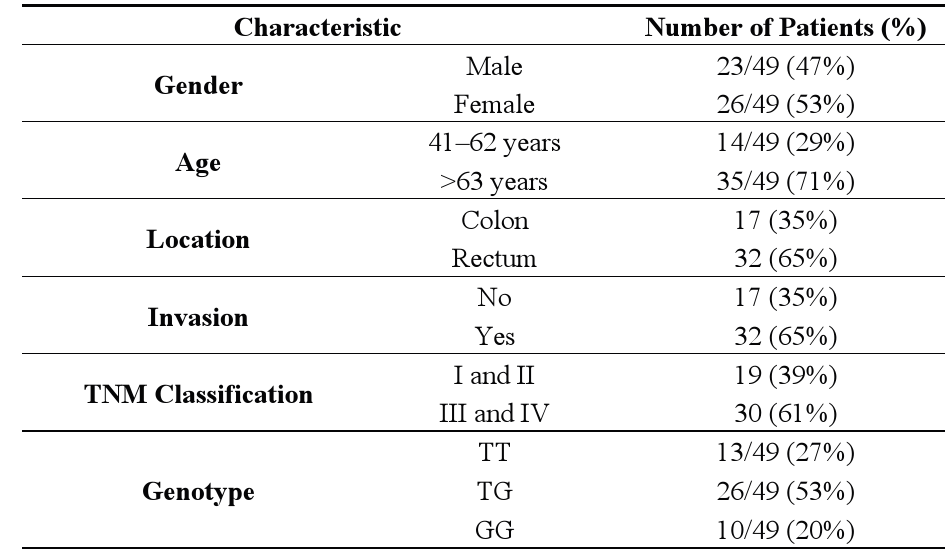
Table 1. Clinical, histopathological and genotypic characteristics of the samples. TNM, the tumor node